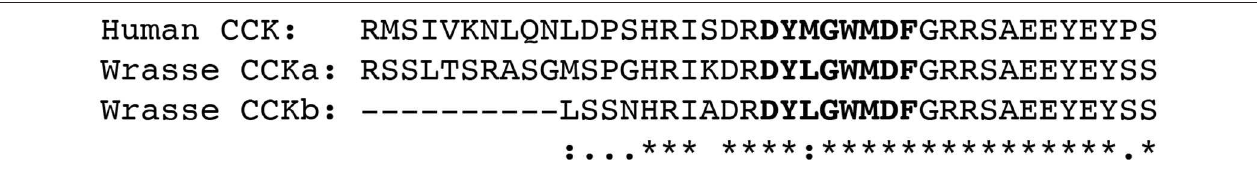
resolution of 1,024 × 768 pixels. The capture of the time lapse series was controlled with the NIS-Elements Confocal